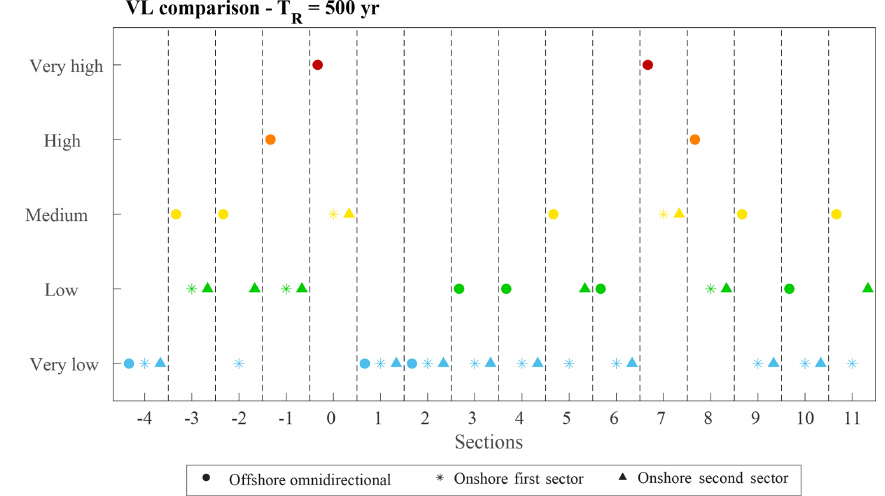
Figure 11. Comparison among the run-up vulnerability indexes for each sampling location; return period equal to 500